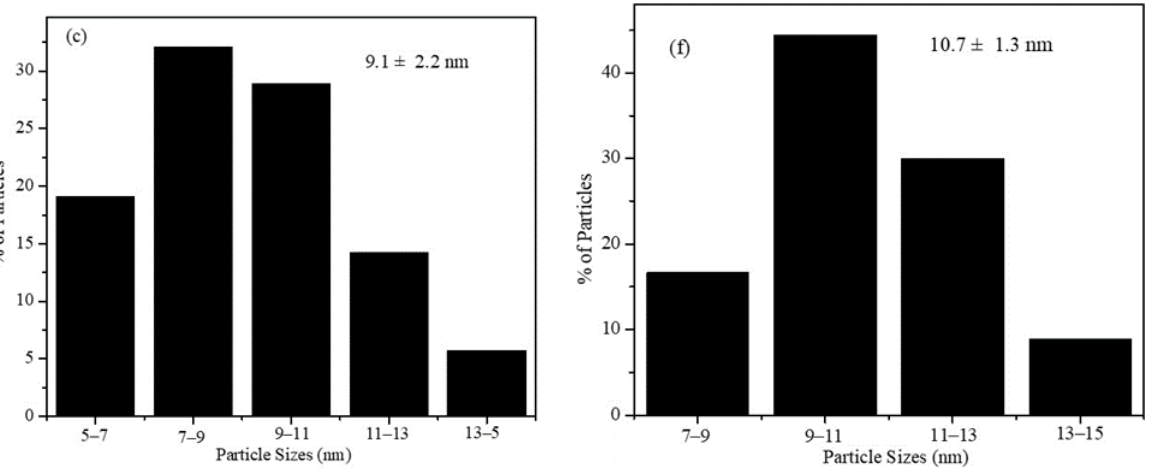
Figure 3. TEM bright-field images, SAED patterns, and size-distribution histograms of the S1 ( a – c ) and S2 ( d – f ) core-shell nanoparticles.